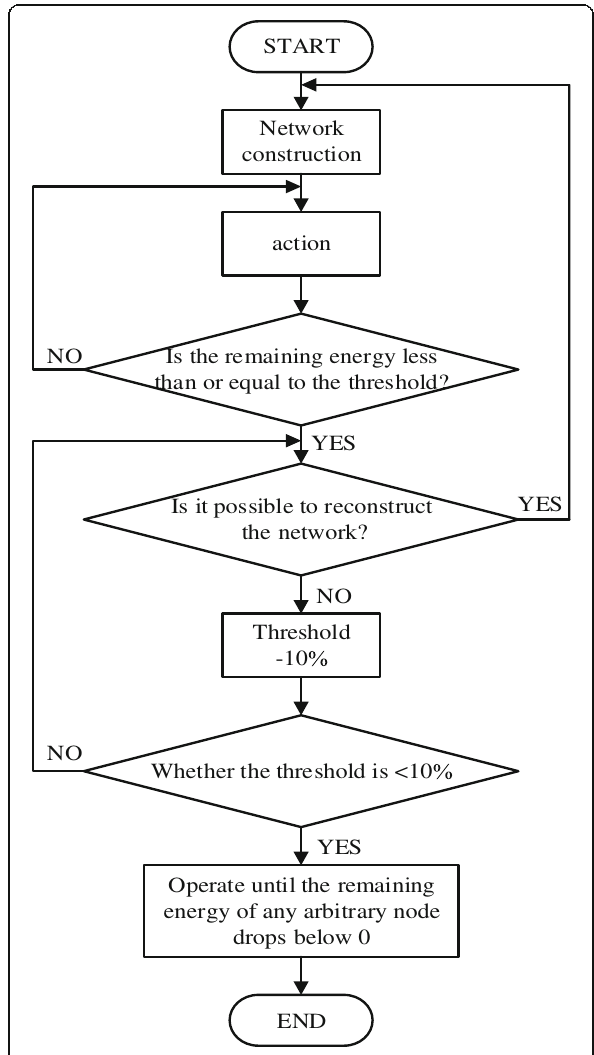
Fig. 14 Flow chart of reconstruction method with variable threshold. This figure shows the flow chart of a network reconstruction method based on a variable power threshold. As shown in the figure, when the remaining rate of battery energy of any router drops below the threshold that is set to 80%, network reconstruction is performed. It is required that nodes whose remaining power is below the threshold cannot be set as a router. If network reconstruction becomes impossible in the current threshold, the threshold is reduced by 10%. In this case, the node with the remaining power higher than the threshold can be set as the router, and the node below the threshold can only be set as the end-device. In this way, the threshold decreases with 10% step size, and network reconstruction is carried out in a circular way. When the threshold becomes less than 10%, the network structure is maintained and the operation of the network is performed until the remaining energy of any node is below As shown in Fig. 5, nodes that can communicate with each other are first connected by dashed lines to create an adjacency matrix. Here, 1 indicates a connection state, and 0 indicates a non-connection state. Next, the